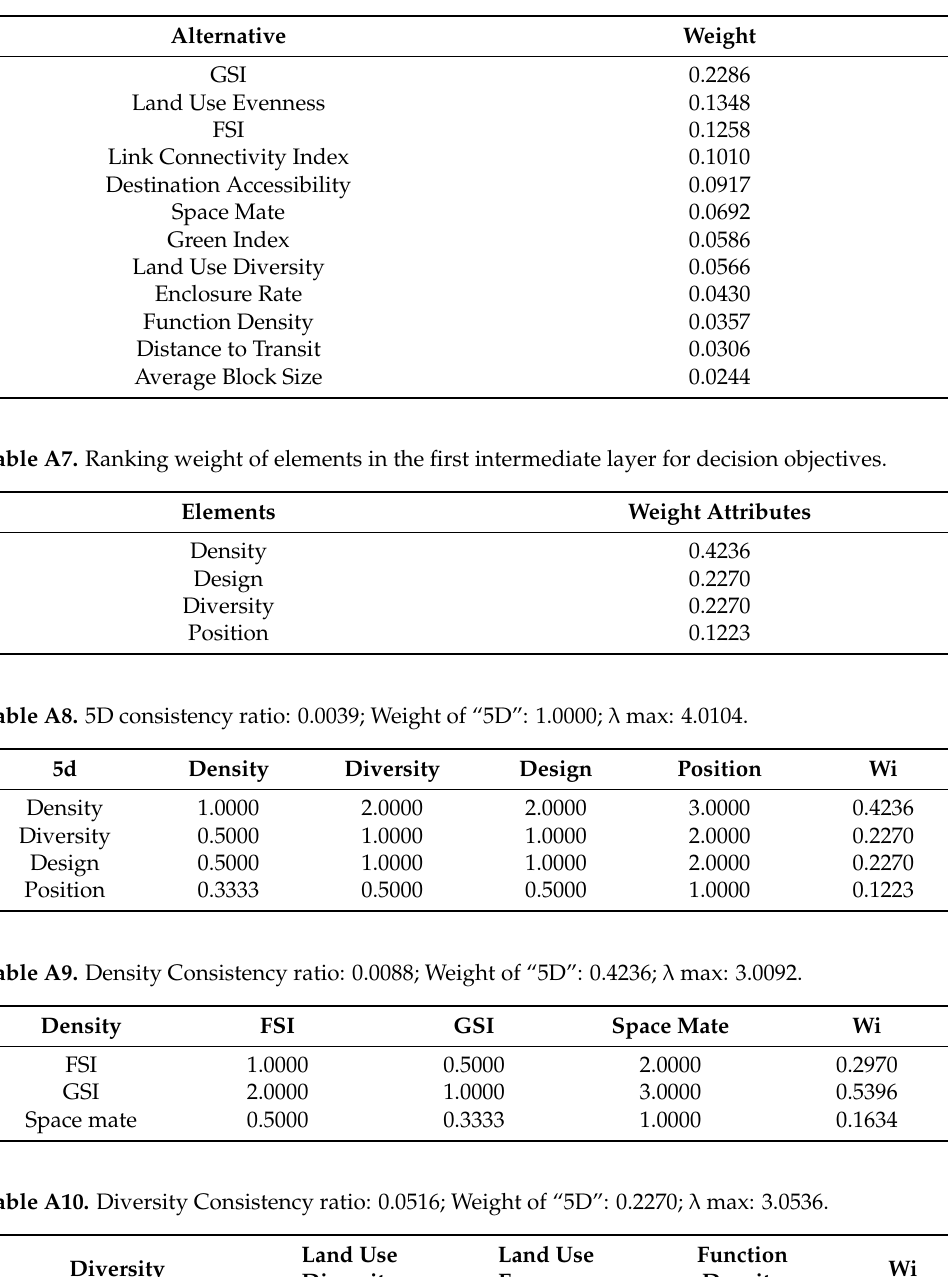
Table A6. Ranking weight of elements to decision objectives in scheme level.